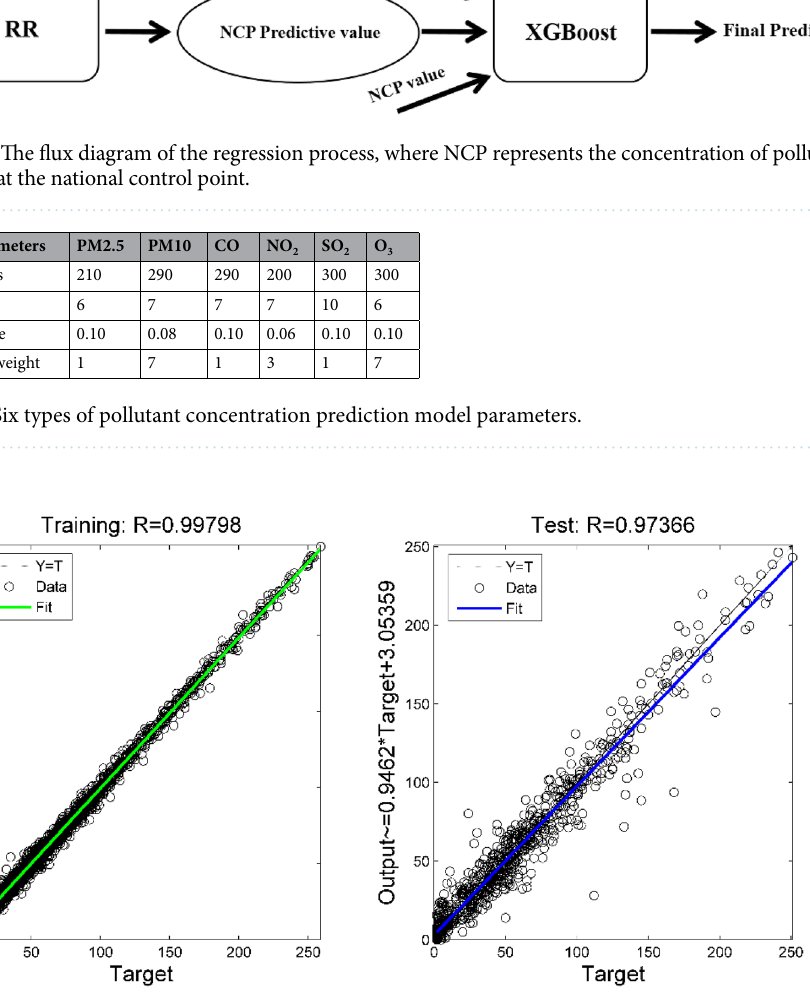
Figure 7. The prediction effect of O 3 ’s RR-XGBoost model on the training set and test